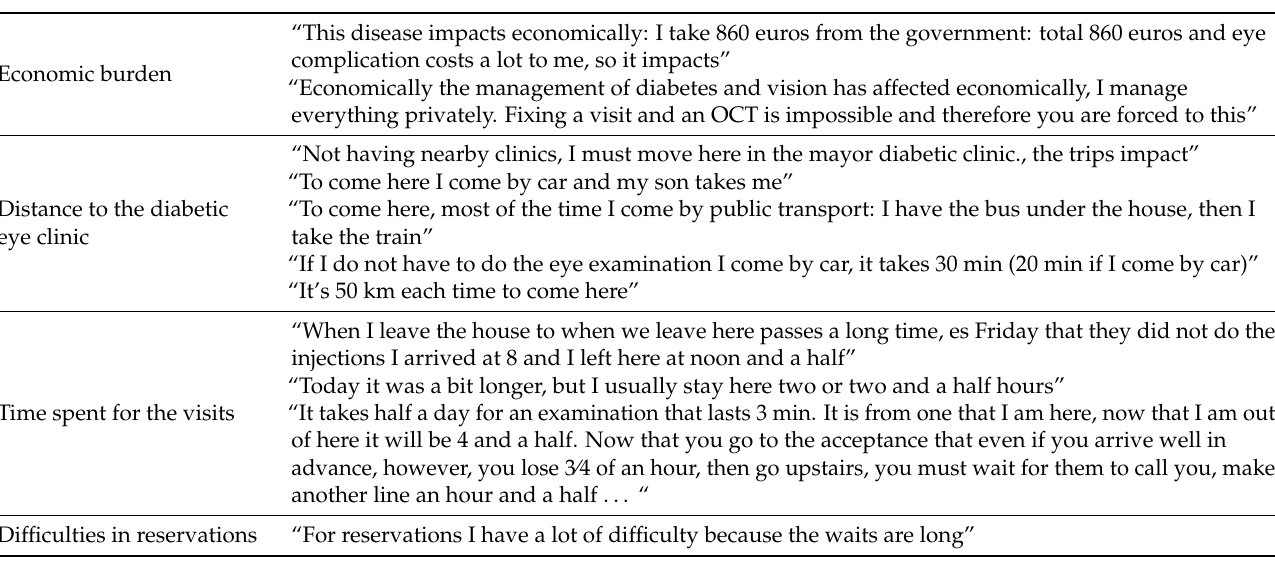
Table 6. Main issues in